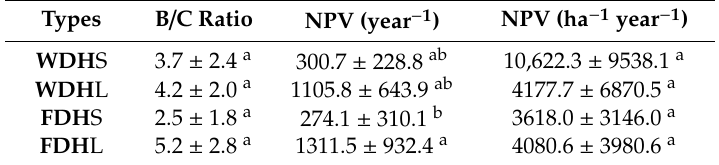
Table 5. Quantified economic value of di ff erent types and sizes of the home